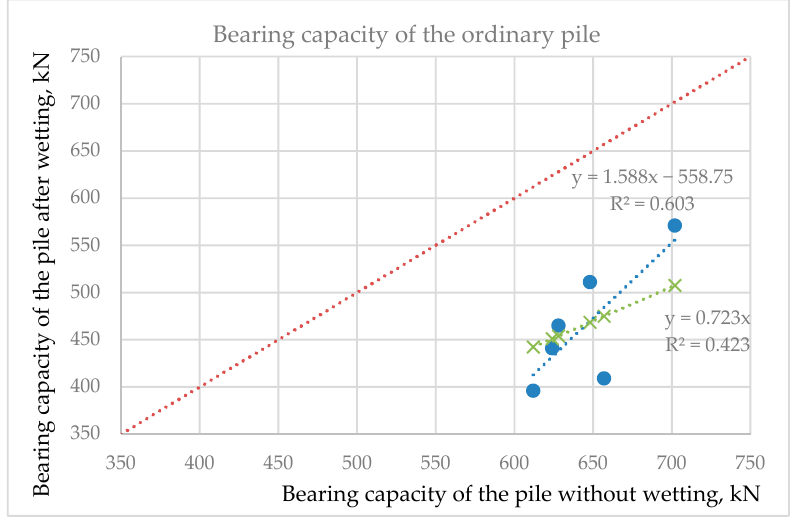
Figure 12. Comparative diagram of the bearing capacity of ordinary piles with and without wetting.